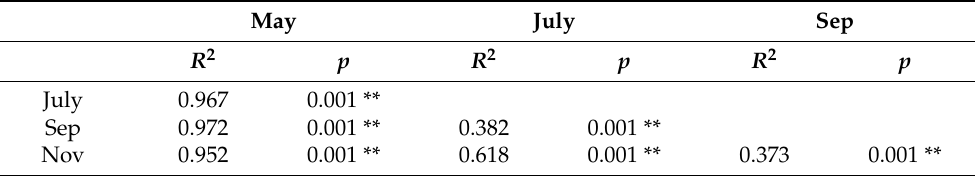
Table 1. Anosim analysis between sugarcane growth stages.